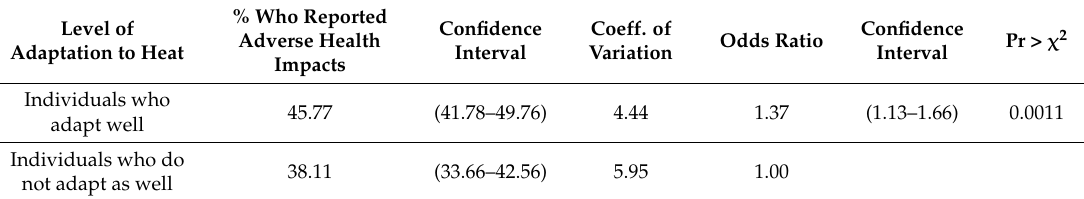
Table 4. Prevalence of self-reported adverse health impacts of high heat and humidity conditions according to the adaptation index and